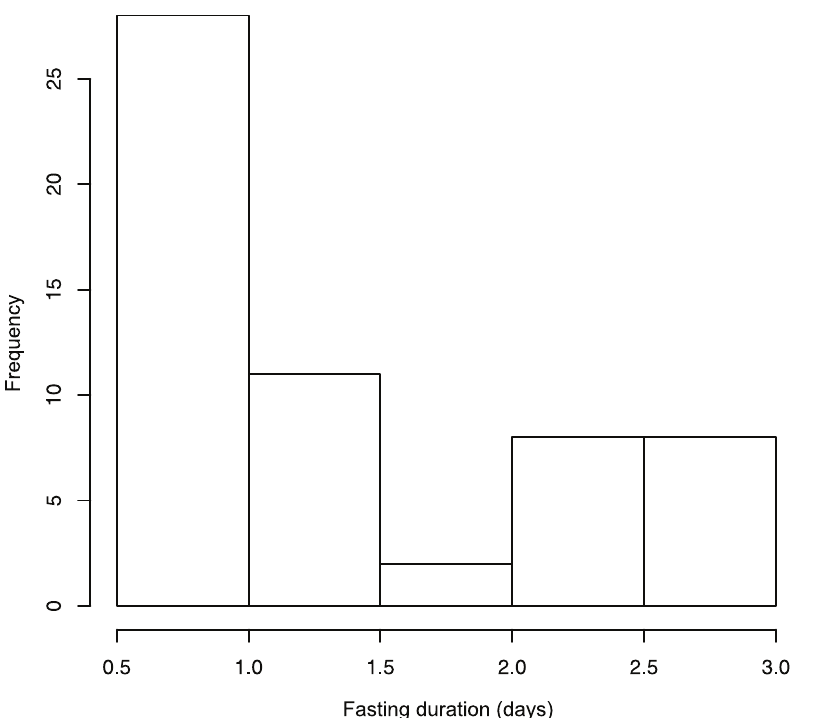
Figure 2. Frequency of fasting duration at the time of measurements of incubation metabolic rate in ancient murrlets at Reef Island in 2010.